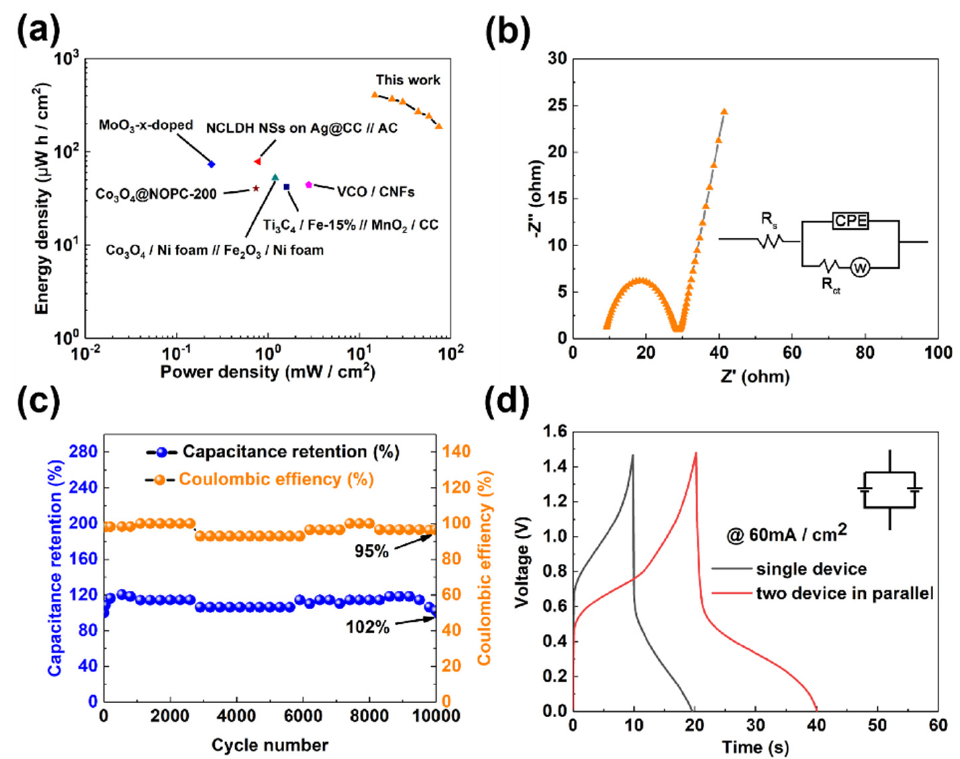
Figure 8. Electrochemical performance of the ASC device in the configuration of CNT/CC/0.2 M Fe 2+/3+ + 1 M H 2 SO 4 //1 M H 2 SO 4 /WO 3 /CC. ( a ) Ragone plot of ASC device in comparison with other results in literature; ( b ) Nyquist plot of the device; ( c ) multi-cycling test of the device; and ( d ) GCD curves of two devices connected in parallel.